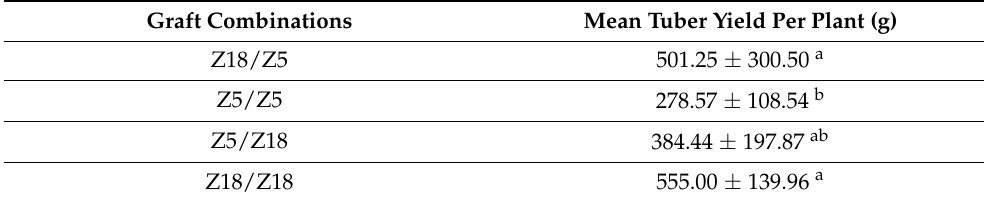
Table 1. Analysis of mean tuber yield per plant of four grafted combinations.